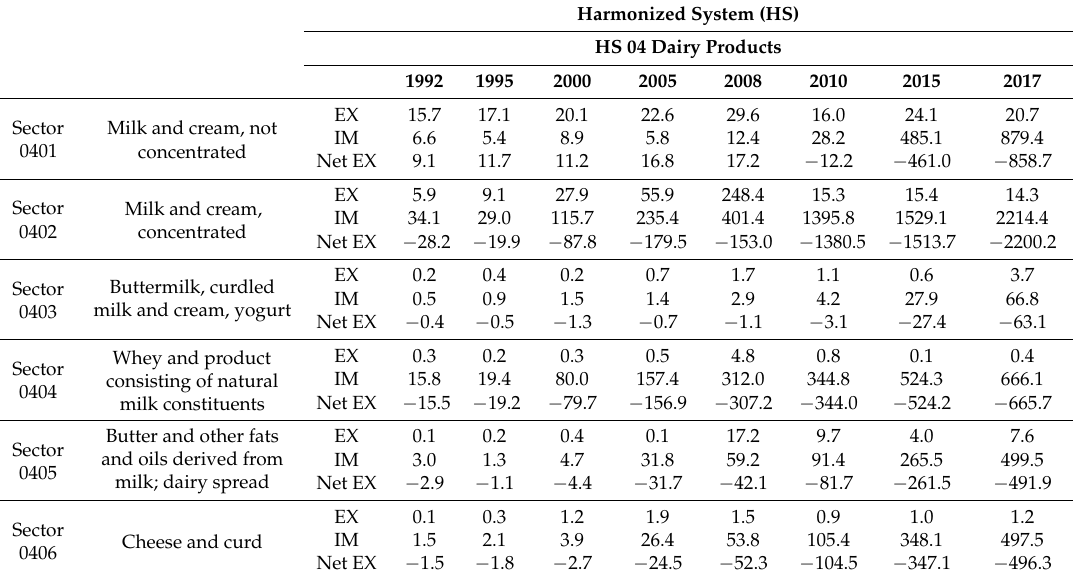
Table 2. China dairy imports and exports at sectors (Unit: USD in